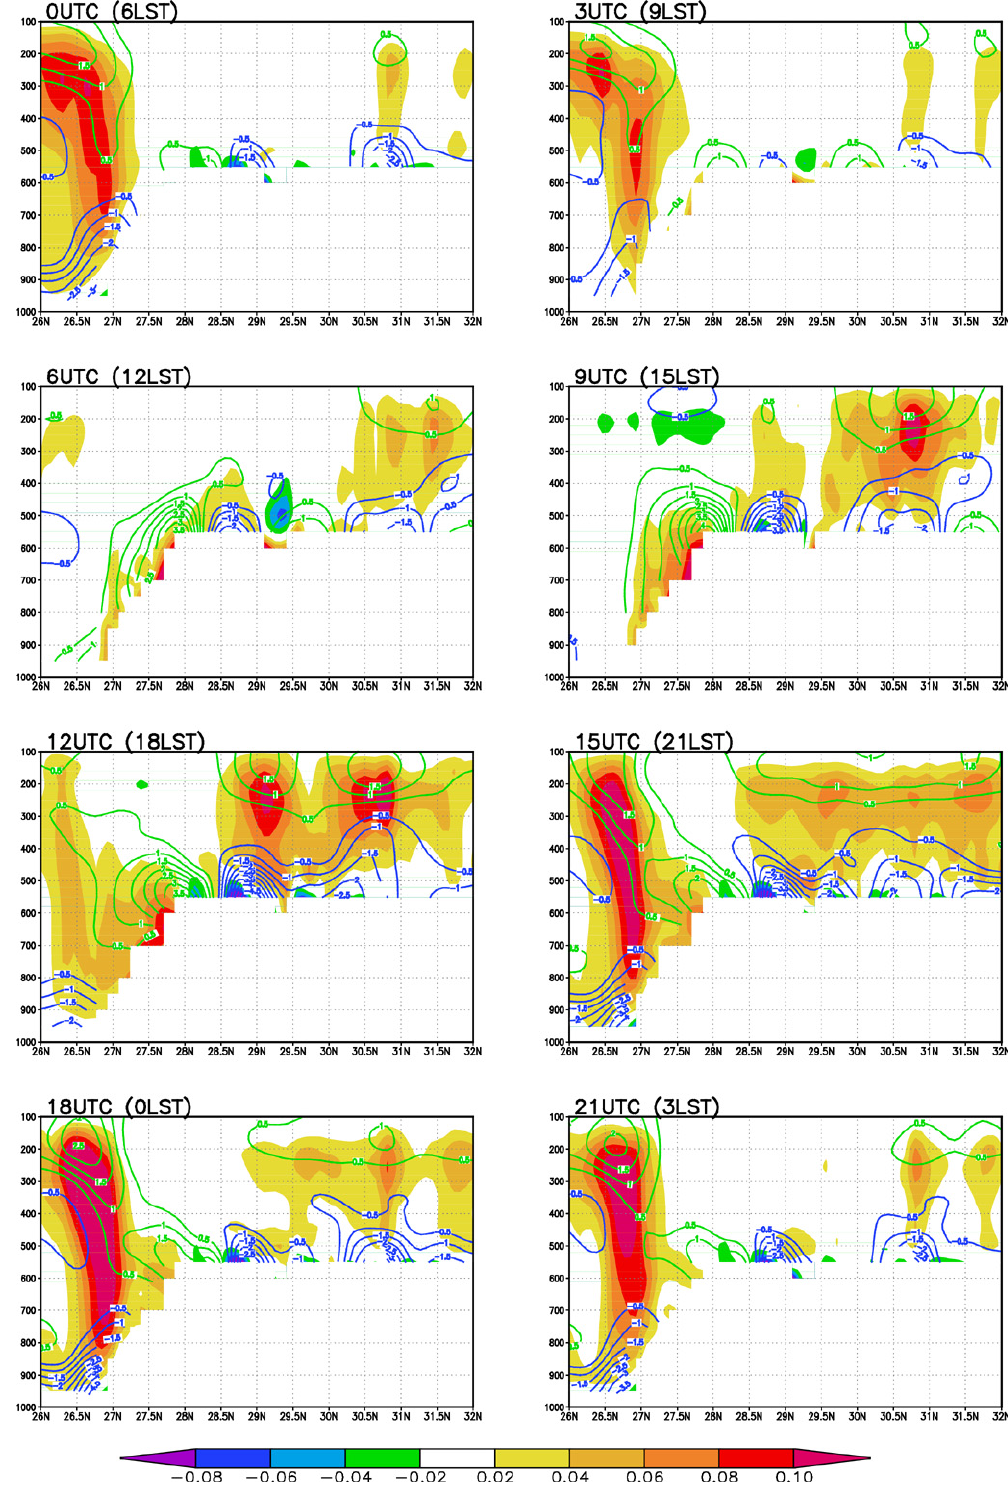
Fig. 10. Latitude-pressure cross-section averaged over 88 ◦ –92 ◦ E for vertical velocity (shaded, ms − 1 ) and the divergence (contoured, × 10 − 5 s − 1 , where green solid indicates divergence and blue dashed indicates